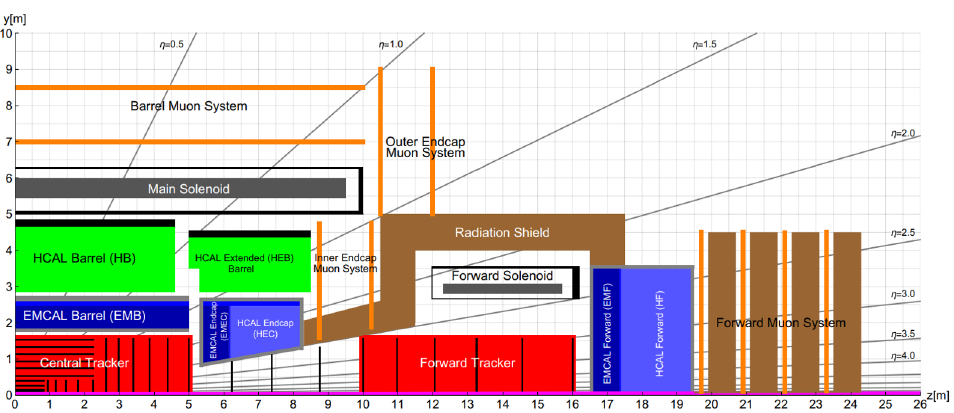
Figure 3 . The longitudinal cross section of the FCC-hh reference detector at one of two main experiments. The figure is taken from